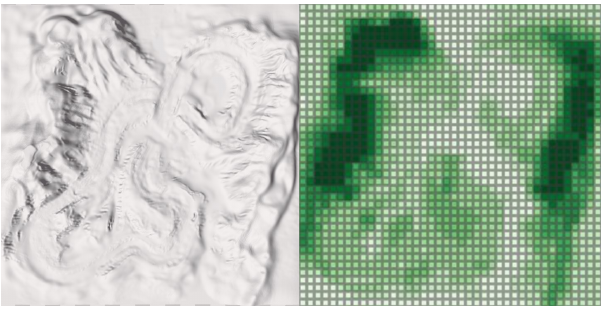
Figure 2. A test environment and extracted height map on 40 × 40 regular grid.